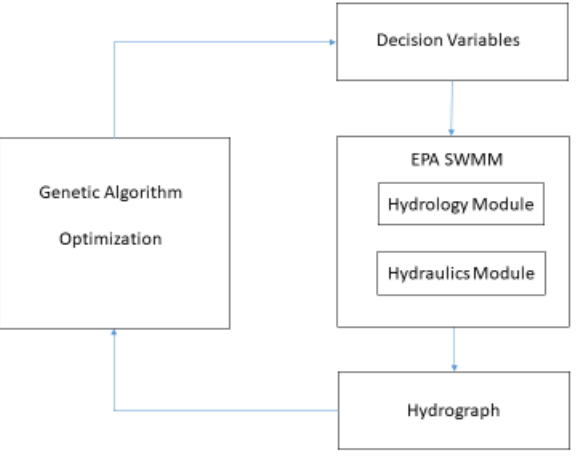
Figure 4. Flowchart of GA.